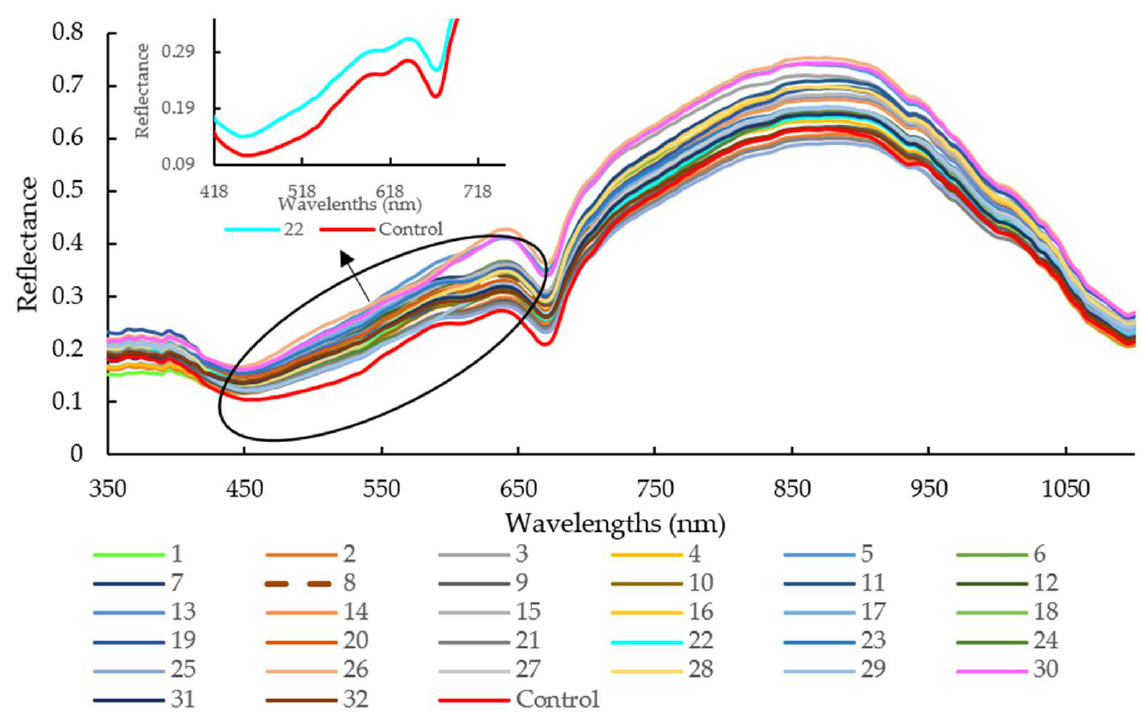
Figure 2. Spectra of all raw samples with different modified casing treatments in the spectral range of 350 to 1100 nm. Note: legend number means different treatments